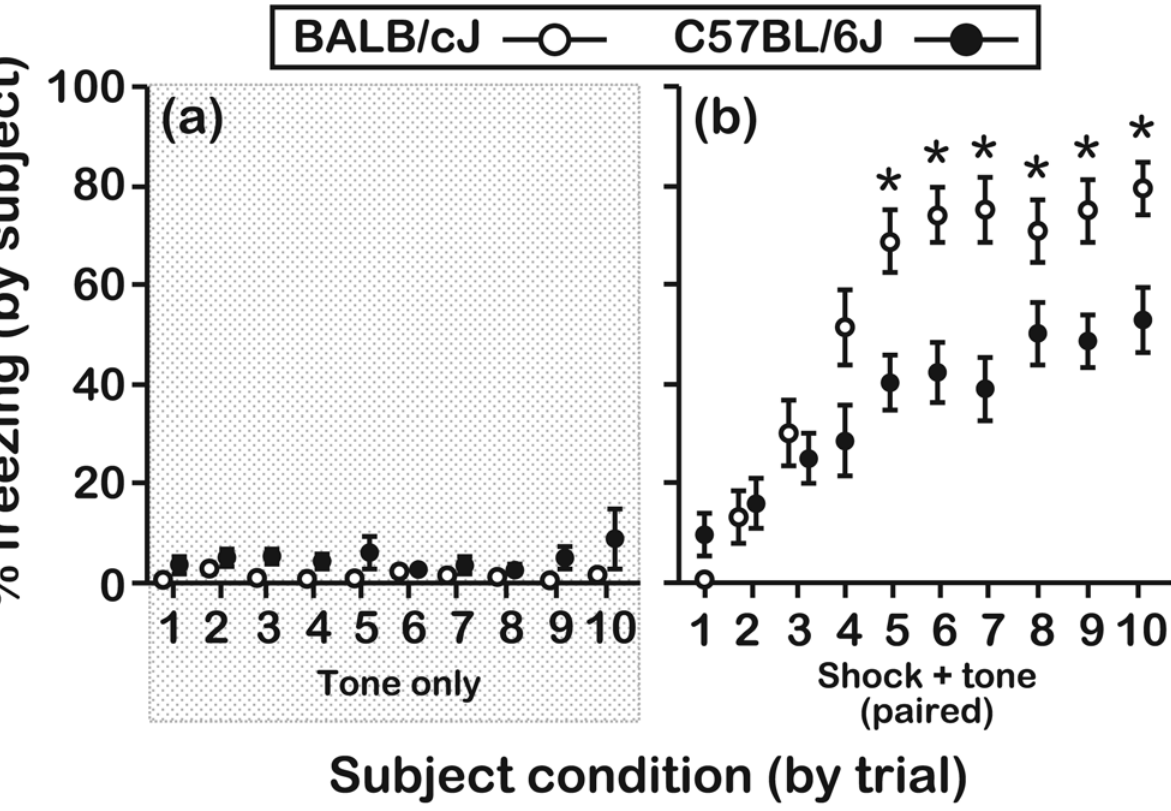
Figure 2. Freezing responses of test mice during direct presentation of the CS-only or the paired CS-UCS. (a) When mice were not pre- exposed to objects or conditioned themselves, there was no strain difference in freezing to the CS (N=12 mice/genotype; age=6–7 wks). (b) BALB mice expressed longer freezing responses than B6 mice on trials 5-10 when they had not been pre-exposed to objects, but were directly exposed to the CS-UCS contingency (N=16 mice/genotype; age=7–8 wks). Asterisks represent significant differences between BALB and B6 mice as assessed by a Bonferroni step-down procedure on a trial-by-trial basis ( / =0.005 for each trial). All data were scored in duplicate by 2 independent raters (see the figure legend corresponding to Figure 3 for the inter-rate reliability) and are presented as the mean 6 s.e.m.